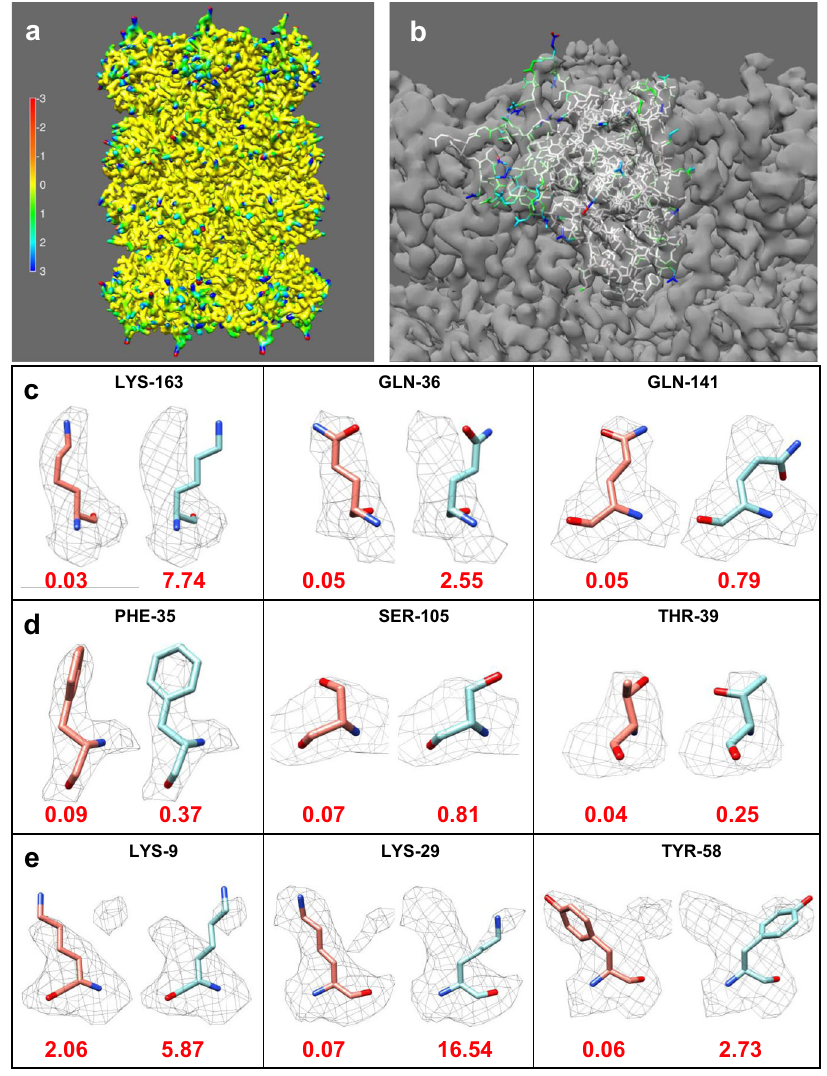
Fig. 1 Detection of map-model fi t errors using FSC- Q . FSC- Q values calculated for the 20 S proteasome structure (EMD-6287) are projected onto the map generated from the atomic model (pdb id: 6bdf) ( a ) or on the atoms of chain Q of the atomic model ( b ). Scale: red indicates atoms that may be associated with noise and blue indicates poorly fi tted atoms or areas with low resolvability. c – e Rotamers of several amino acids in the 20 S proteasome structure that have been altered. In each panel, the original rotamer is shown on the left and the modi fi ed rotamer on the right with their corresponding average FSC- Q - scores. For the calculation of the average, the absolute FSC- Q value of each atom was considered. c Rotamers of three long-chain amino acids that are clearly out of the density (LYS-163 chain B, GLN-36 chain V, and GLN-141 chain T). d Very subtle modi fi cation of the residues: PHE-35 chain 1, SER-105 chain Q, and THR-39 chain R. e Residues in which the modi fi ed rotamers overlap with other densities (LYS-9 chain L, LYS-29 chain R, and THR-58 chain